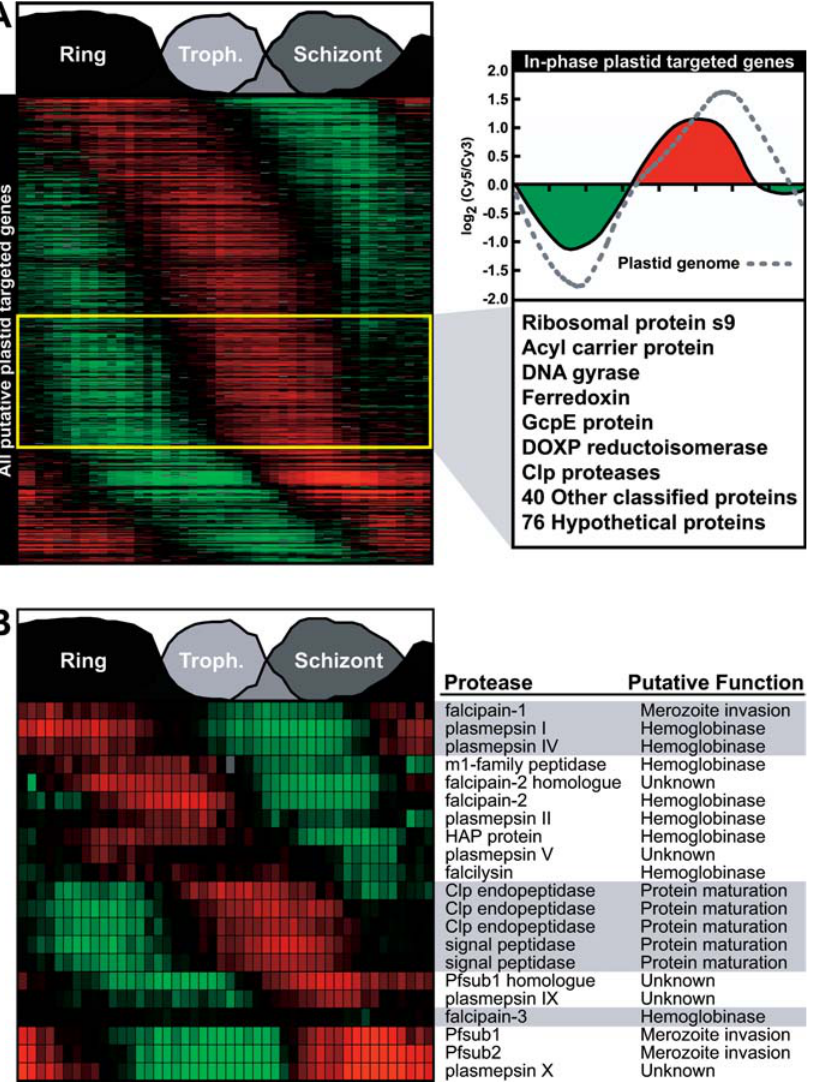
Figure 4. Temporal Distribution of the Apicoplast-Targeted Proteins and P. falciparum Proteases, Potential Antimalarial Drug Candidates (A) The expression profiles of all putative plastid-targeted genes represented on our microarray are shown. The yellow box encompasses a highly synchronized group of genes, which are in-phase with plastid genome expression. The average expression profile for this in-phase group of genes is shown and includes most of the known apicoplast-targeted genes as well as many hypothetical genes. For reference, the average expression profile for the plastid genome is shown (dashed gray line). (B) Proteases represent an attractive target for chemotherapeutic development. The broad range of temporal expression for various classes of proteases and their putative functions are